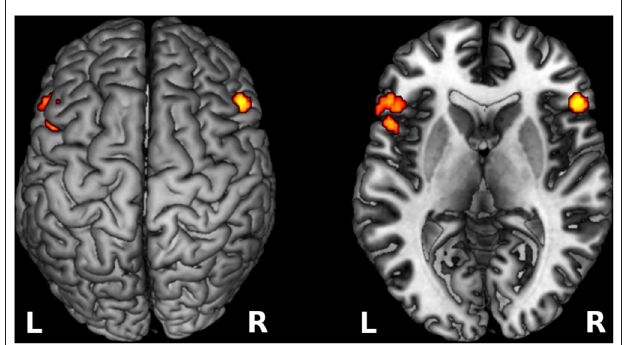
FIGURE 4 | Increased cortical activation for semantic incongruency contrasted with semantic congruency. The figure shows activation in the IFG bilaterally (BA 45) as projected on the cortical surface (left), and the exact locus of activation visible on a transverse cutout slice (right). The visualized results refer to cortical activation that was more prominent during incongruent sentence reading compare to congruent sentence reading. L, left hemisphere; R, right hemisphere.